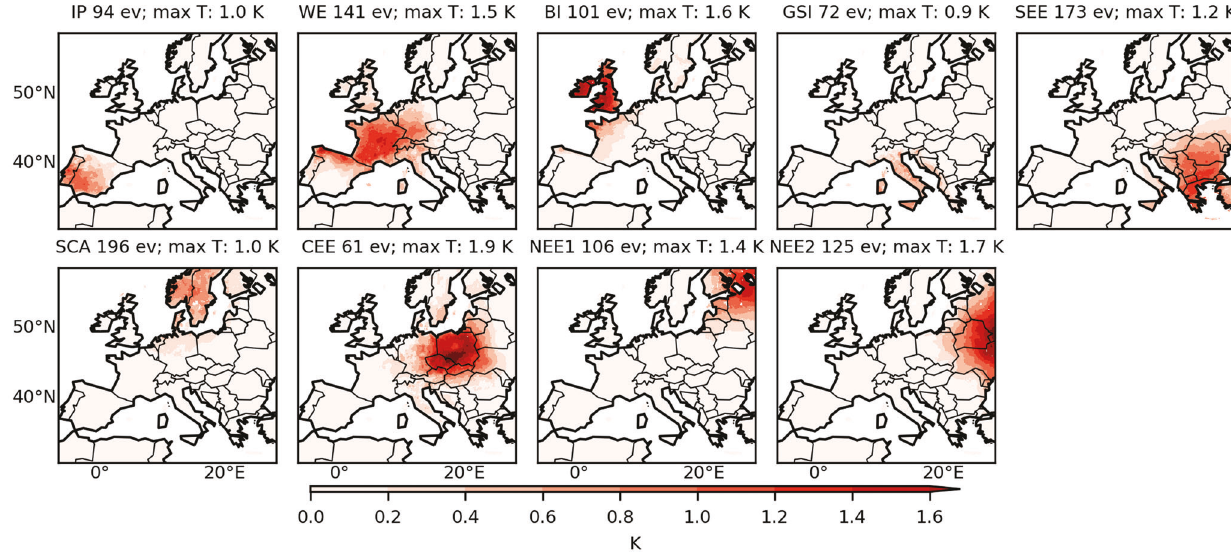
Fig. 3 Nine typical heatwave patterns over Europe derived from E-OBS. In the title from left to right: pattern abbreviation, number of events belonging to the pattern (ev), mean maximum temperature in K. Pattern names same are the same as in Fig. 1, except NEE1: North-Eastern Europe 1, NEE2: North-Eastern Europe